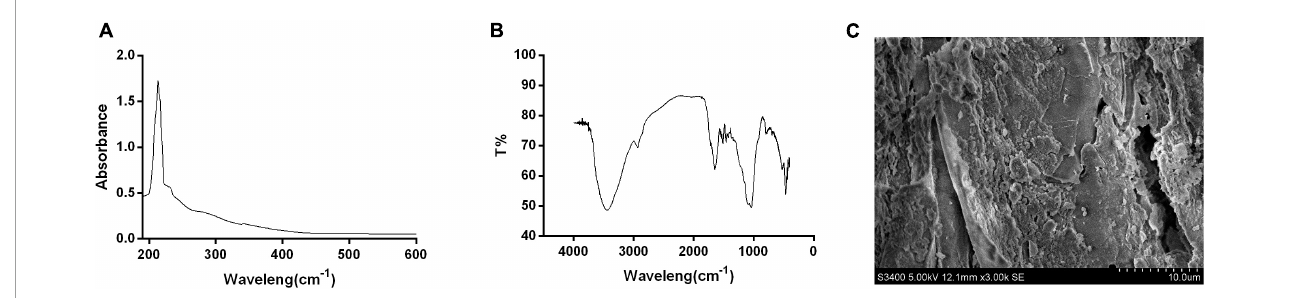
FIGURE3 Structure and shape of A. heimuer melanin (AHM). The structural components and shape of AHM are shown using the UV-visible absorption spectrum (UV-Vis) (A) , Fourier transform infrared (FT-IR) scanning spectra (B) , and scanning electron microscope (SEM) photographs (C) .